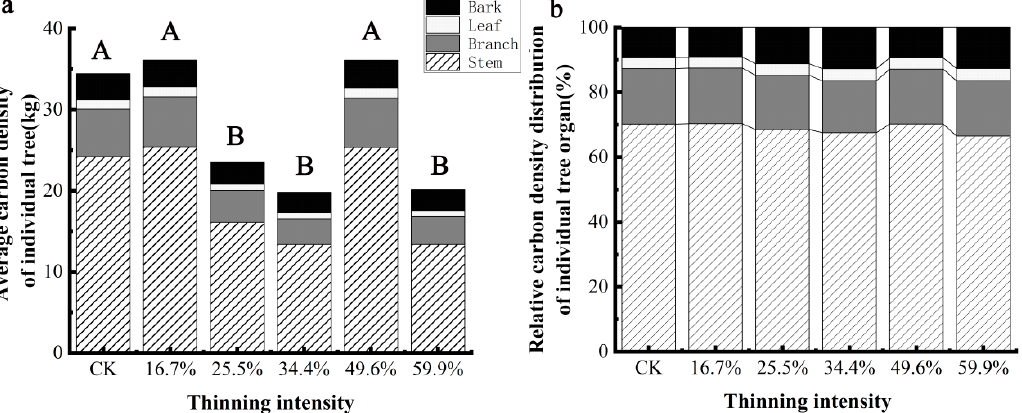
Figure 7. The average individual tree organ carbon density and its allocation of larch. Note: ( a ) is larch average carbon density of individual tree, ( b ) is larch relative carbon density distribution of individual tree organ.The different capital letters in the same graph denote a statistically significant difference at p < 0.05 of the average carbon density between thinning intensity groups.